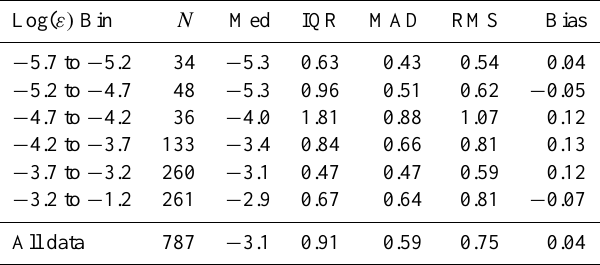
Table 2. Statistics comparing dissipation rates derived from tether- sonde measurements with 15- and 30-m tower measurements during ASCOS. Statistics are representative of tower values within spec- ified ranges of the tethersonde-derived dissipation rates given in the left-most column. All statistics are computed using the loga- rithms (base 10) of the dissipation rates and include the total num- ber of observations ( N ), median (Med), interquartile range (IQR), mean absolute difference (MAD), root mean square difference (RMS), and relative bias between data sets (Bias). For these cal- culations: MAD= P | x − y | / N , RMS=( P [( x − y ) 2 ]/ N ) 1 / 2 , and Bias=2.0/ N · P [( x − y )/( x + y )], where x is the tethersonde data, y is the tower data, and N is the number of samples. All values are in units of log(m 2 s − 3 ) except for N and Bias. The latter can be thought of as a factor relative to the mean value in the range of in- terest. A positive bias in this case, due to the fact that the logarithms are themselves negative, indicates that the tower-derived dissipation rate is larger than that from the